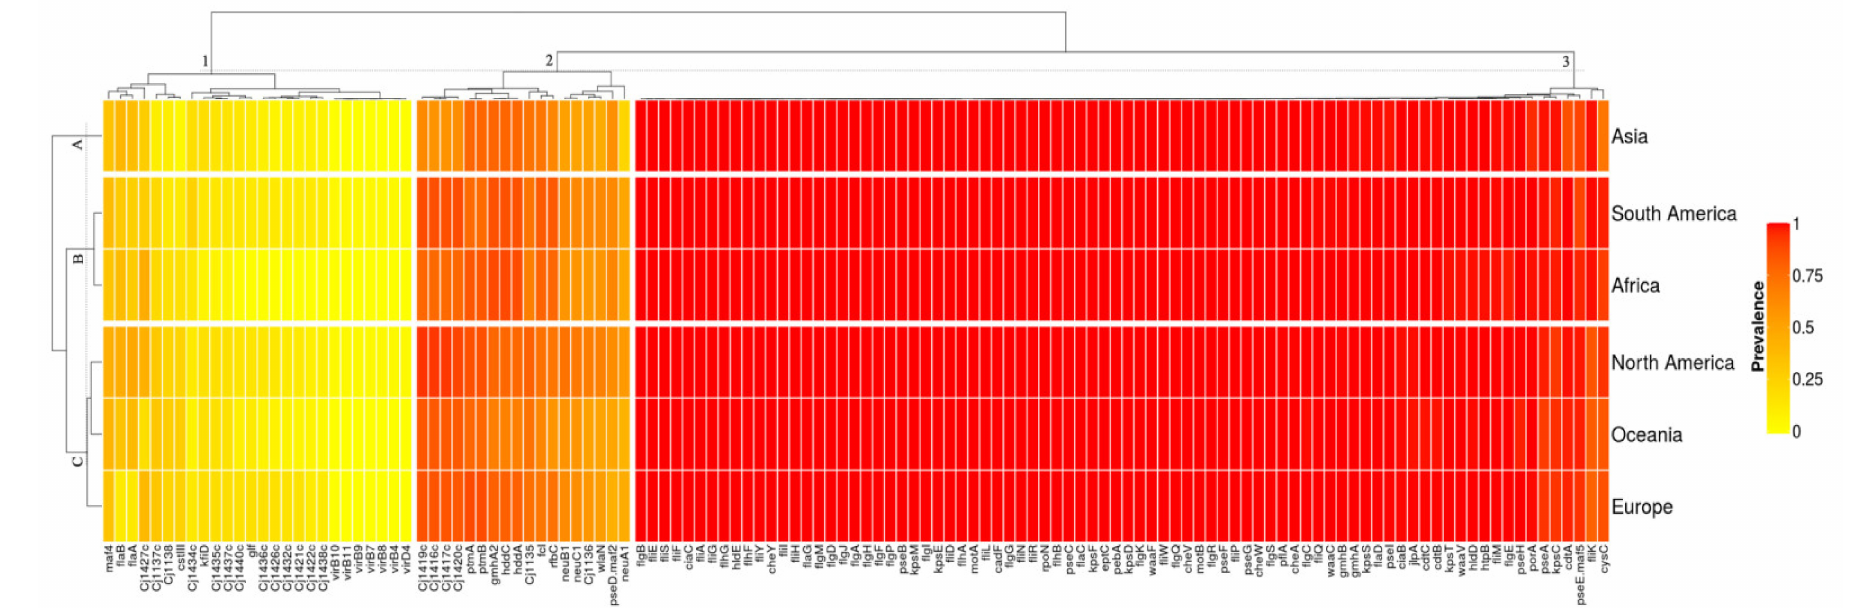
Figure 1. Color heatmap with the 126 virulence genes comprising the C. jejuni virulome of the 40,371 whole genome sequences collected from the NCBI Pathogen Detection Database. The prevalence ranges from 0 to 1, in which 0 (yellow) is the least prevalent, and 1 (red) is the most